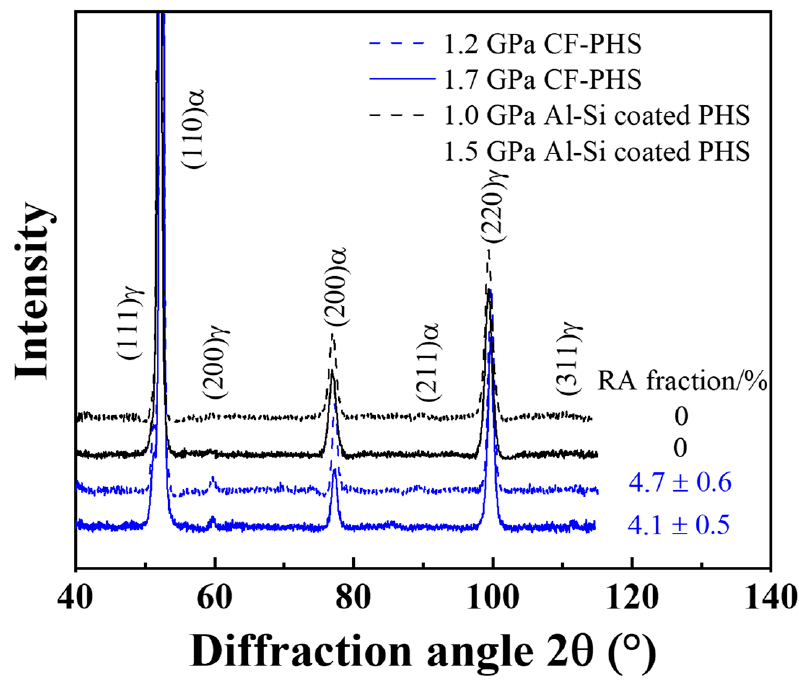
Figure 7. XRD pattern showing the peaks of austenite and martensite for all PHSs.